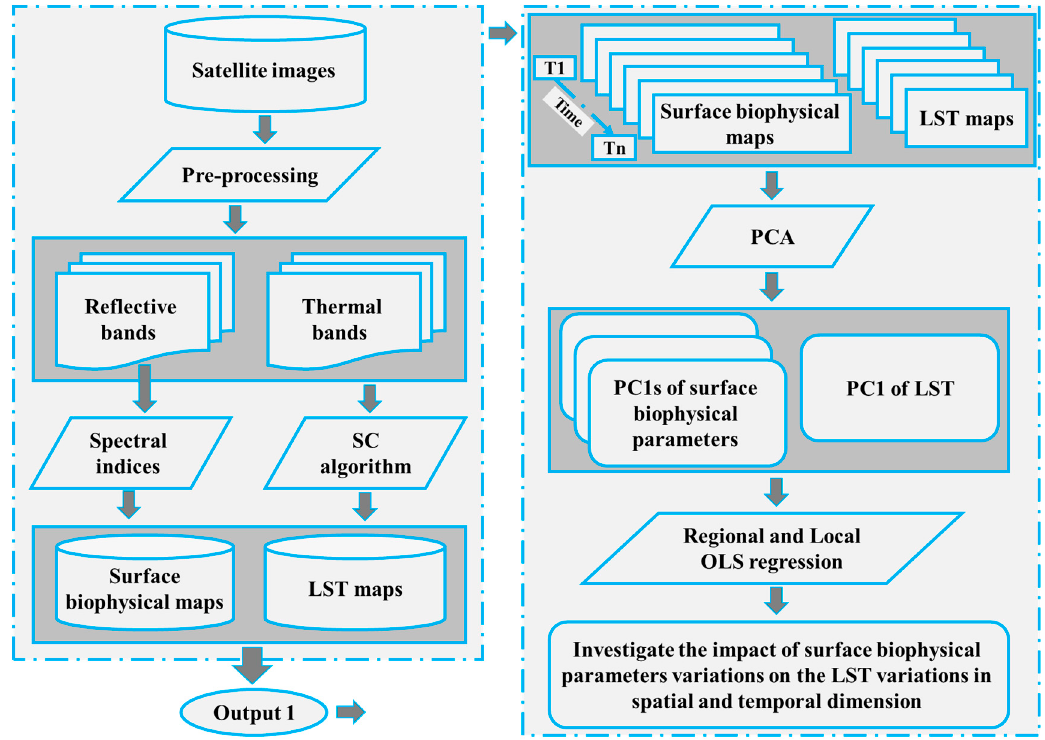
Figure 3. The flowchart of the analytical procedures.